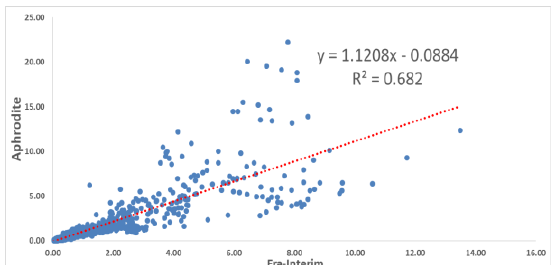
Figure 16. Scatter plot between daily rainfall in MAM season of Era-Interim and APHRODITE rainfall products